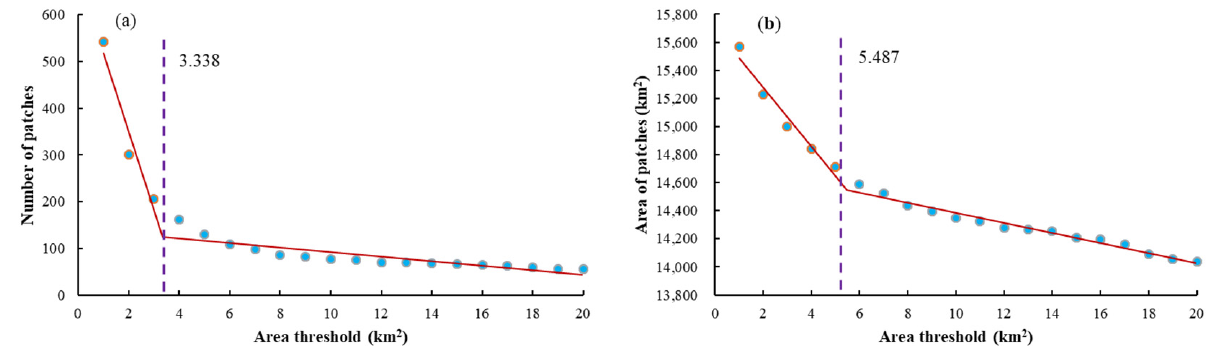
Figure A3. Number ( a ) and area ( b ) of ecological sources under different area thresholds in 2020. Appendix B. Calculation Process of Habitat Quality for Terrestrial Ecosystem In this study, the habitat quality module of InVEST model [58] was applied to gener- ate a habitat quality map of terrestrial ecosystems, and the calculation formula is as fol- lows: